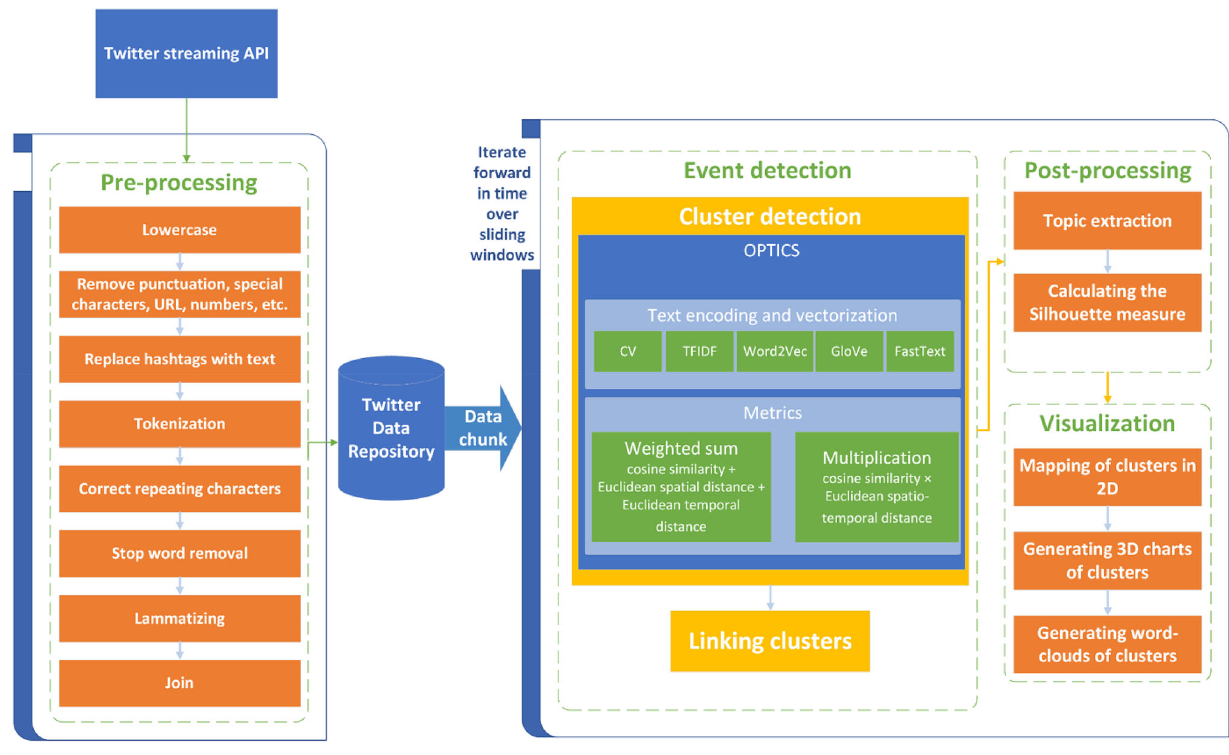
Fig. 1 The overall architecture of dynamic spatio-temporal tweet mining